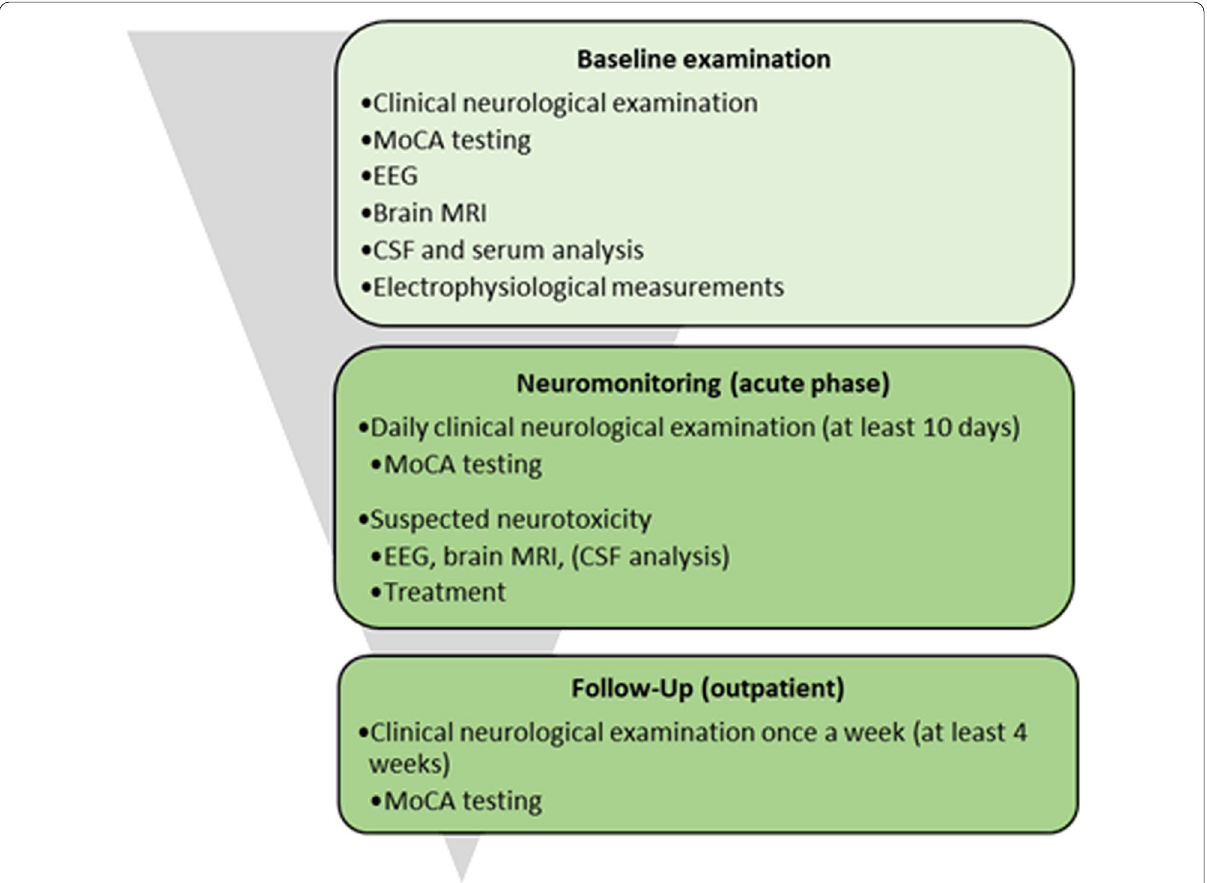
Fig. 1 Hannover cohort neurological examination and monitoring before, during and after CAR T cell treatment. CSF: cerebrospinal fluid; EEG: electroencephalography; MoCA: Montreal Cognitive Assessment; MRI: magnetic resonance